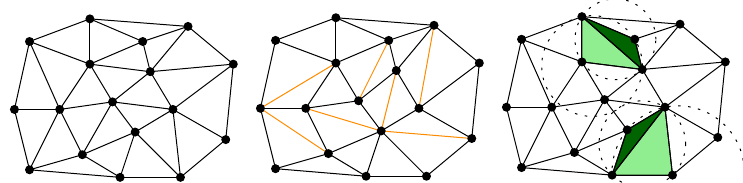
Figure 1. Three higher order Delaunay triangulations of the same set of points, with three different orders: k = 0 ( left ), k = 1 ( center ), and k = 2 ( right ). Order-1 edges shown in orange, order-1 triangles shown in light green, order-2 triangles shown in dark